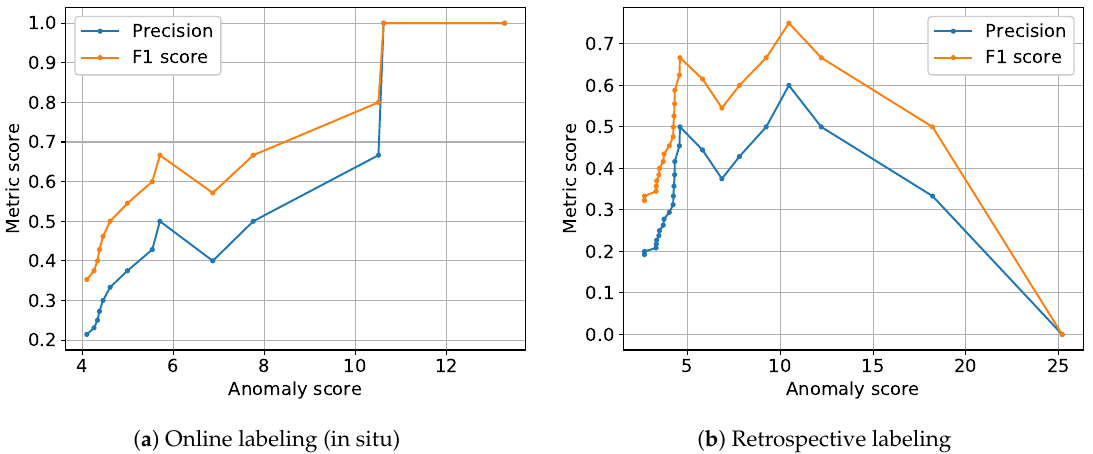
Figure 8. Dependency of metric scores (precision, F1 score) for label feedback on the height of anomaly scores of the NC model (cf. Assumption 2a): For online labels ( a ), the dependency between likelihood of confirmation of proposed anomalies and height of anomaly scores is clearer than during retrospective annotation ( b